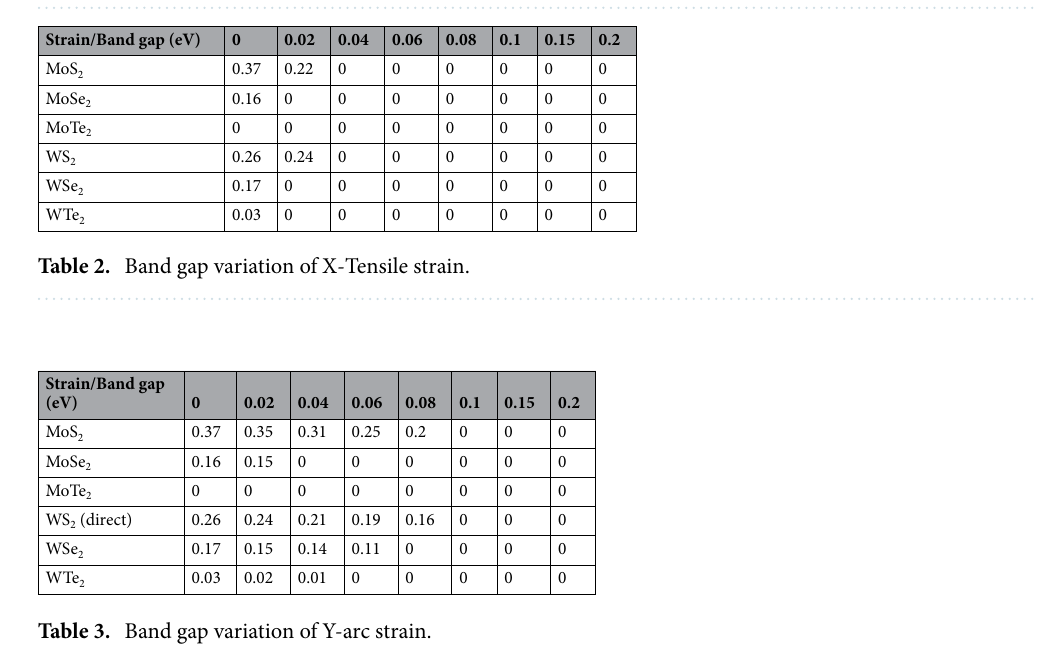
Figure 3. Electronic band structure of WX 2 (X = S, Se, Te) for two types of strain labeled as uniaxial X-tensile and Y-arc strain with c = 0, 0.04, 0.08.